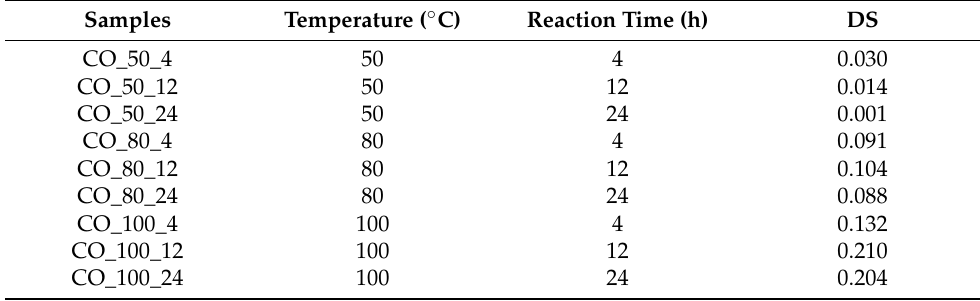
Table 1. Degree of substitution (DS) of cellulose oleates at different reaction conditions.